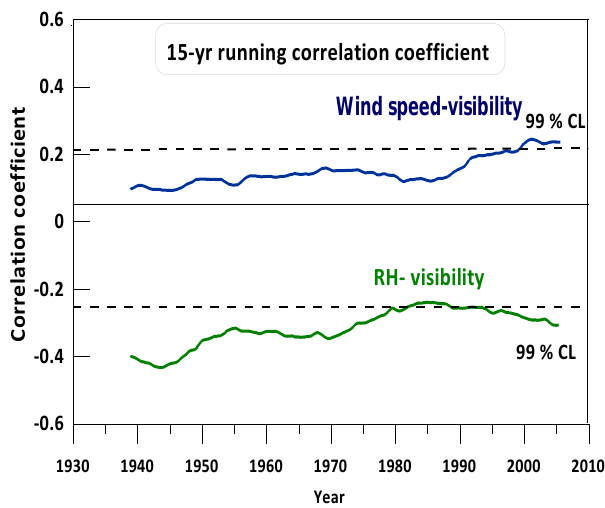
Figure 9. Running correlation coefficient and 99% confidence lev- els (CL; dashed lines) between visibility and wind speed (blue line) and visibility and RH (green line) in Athens, over the period 1931– 2013. A 15-year window was used.